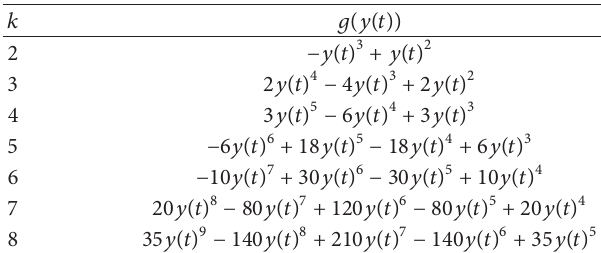
Table 1: The polynomial of the right-hand side of (13) for various values of 𝑘